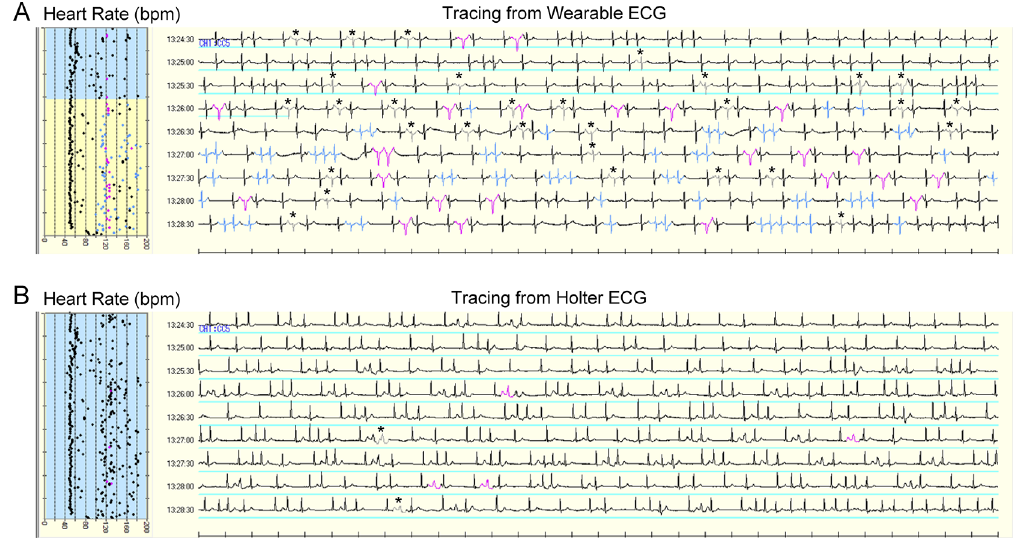
Figure4.SimultaneoustracingsofautomaticinterpretationfromwearableECG(A)andHolterECG(B). Timein atrial fibrillation was indicated by the blue line. Most noise signals on wearable ECG were labeled as normal QRS complexes on Holter ECG. The gray signal with asterisk indicates noise; black signal, normal QRS complex; blue signal, atrial premature complex; pink signal, ventricular premature complex. ECG,